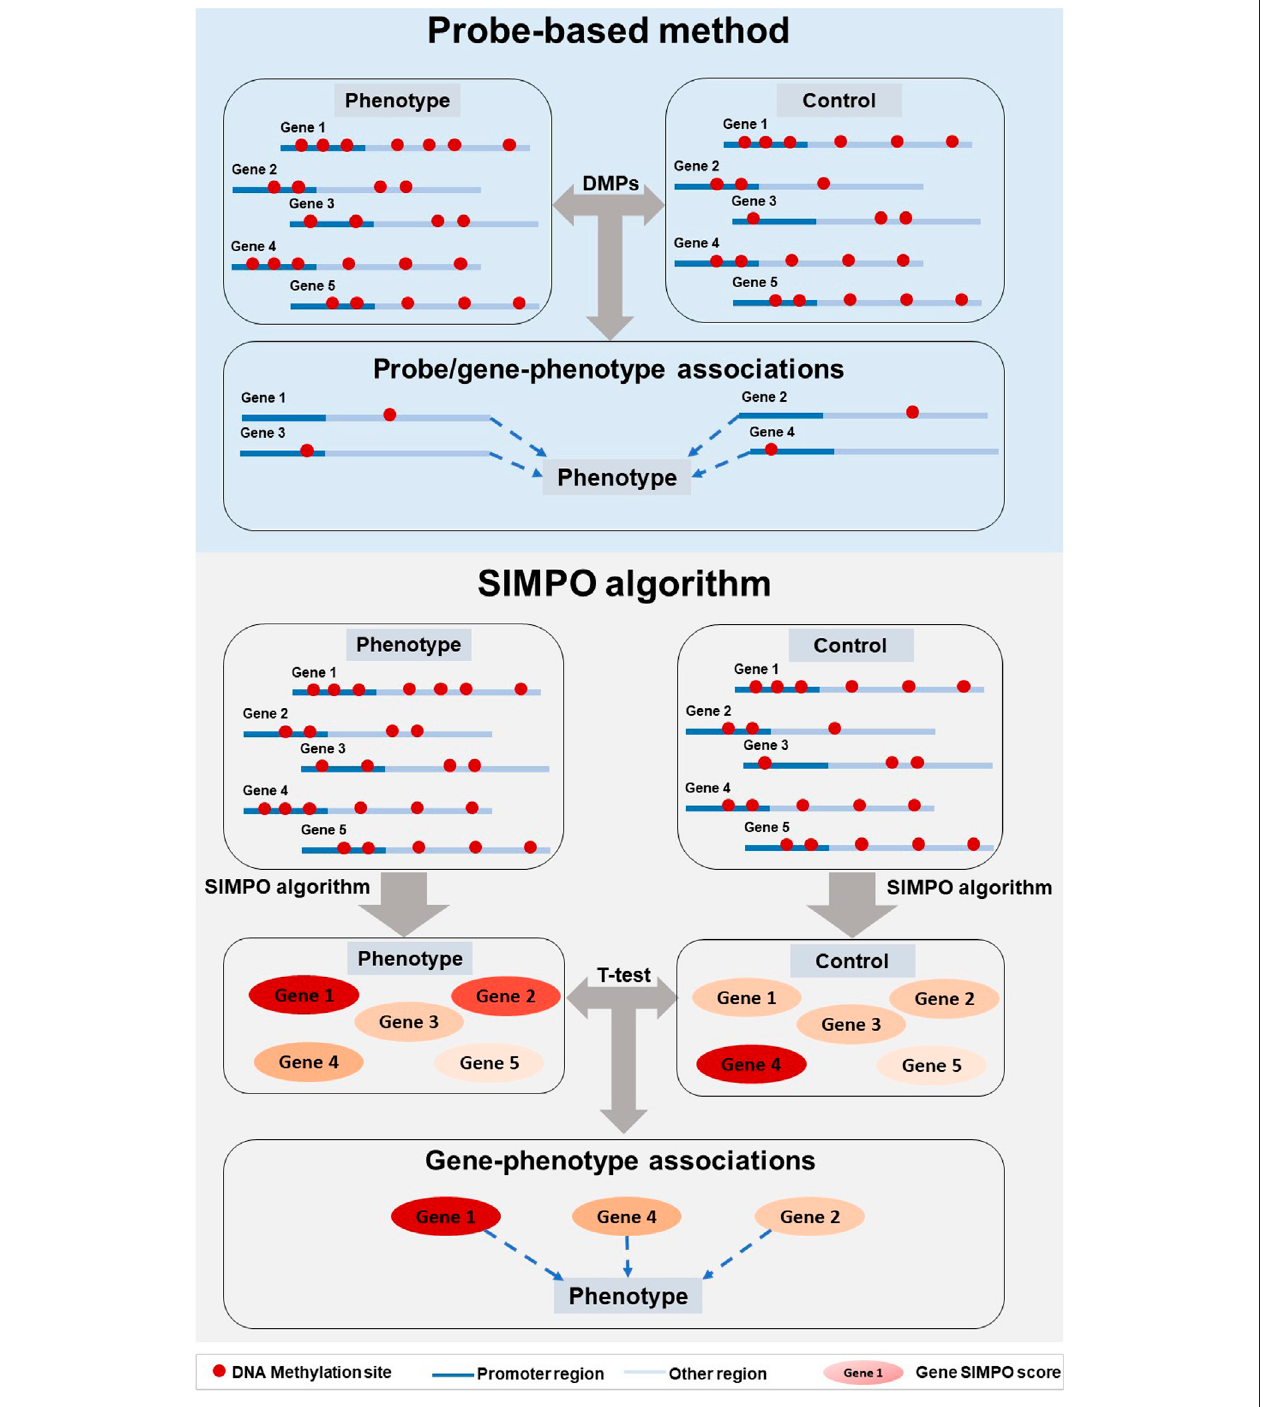
FIGURE 2 | Pipeline comparison of probe-based method and SIMPO